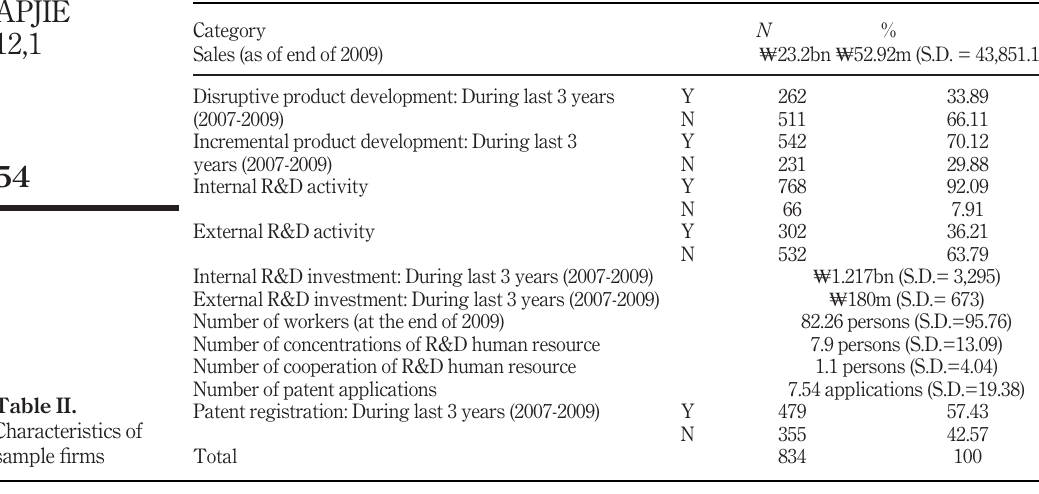
Table II. Characteristics